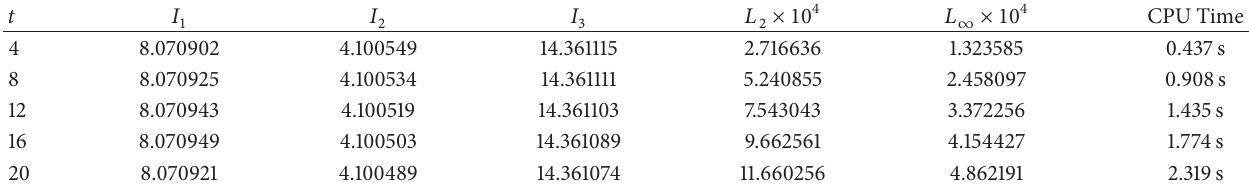
Table 4: Invariants and error norms for single solitary wave with 𝑐 = 0.6 , ℎ = 0.1 , 𝑘 = 0.1 , −40 ≤ 𝑥 ≤ 60 .